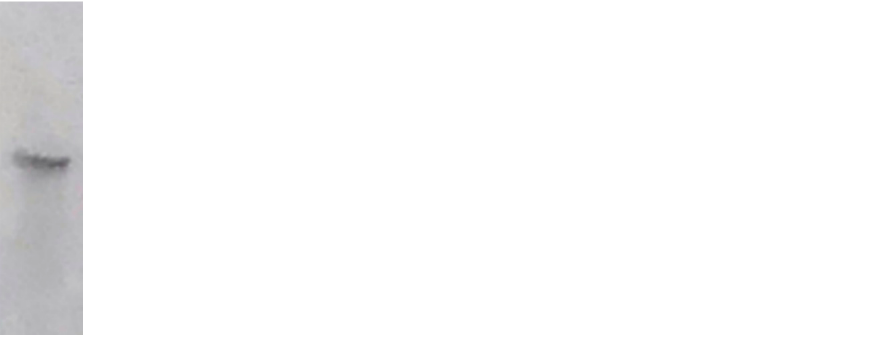
Figure 1. Verification of the severe acute respiratory syndrome coronavirus 2 (SARS-CoV-2) N protein using electrophoresis. A single band of approximately 50 kDa was recognized for SARS-CoV-2 N. Three samples with different antibody titers from patients with COVID-19 were used as positive controls. To reduce the difference between assays, the index value was used; the average of the negative samples in the plate, excluding those with high or slightly high values, was considered to have an index value of 0, and the average from three positive controls was determined to have an index value of 8. The mean (standard deviation) index value of negative samples within each plate became 0 (0.2–0.3), and the mean (standard deviation) index value of the three positive samples in all 13 plates tested was 10.13 (0.57), 8.33 (0.03), and 5.63 (0.54),